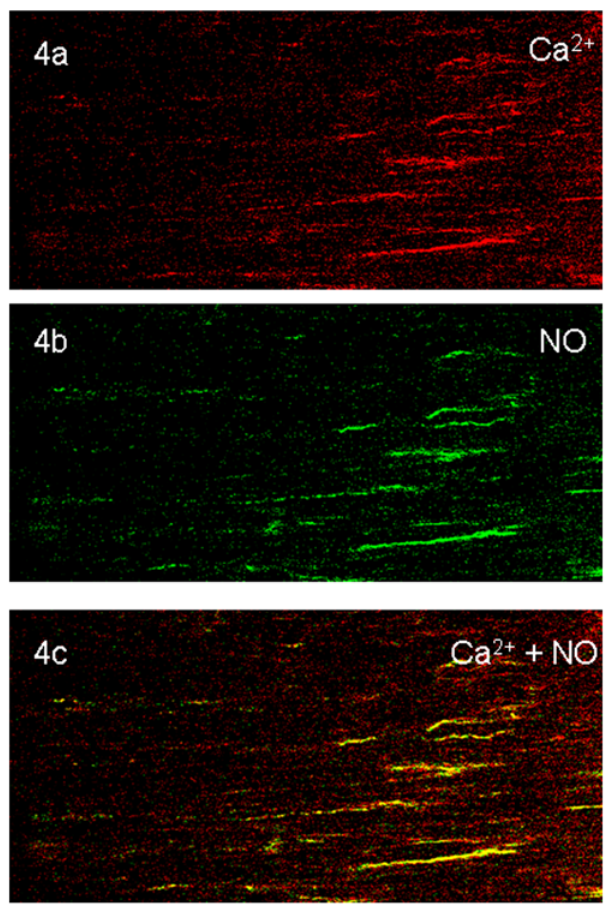
Figure 4. Colocalization NO signals with nNOS immunoreactive varicosities. In this experiment the muscle strip that was preloaded with DAF-2 under NANC conditions, applied EFS and then fixed was immunostained with anti-nNOS antibody. The NO signals are long lasting as the reaction of NO with DAF-2 to form DAF-2T is irreversible. Top panel shows imaging for NO and reveals spots of green fluorescence, representing NO in the varicosities. Note that smooth muscle cells showed no NO signals. The middle panel shows the same section imaged for nNOS immunofluorescence. The bottom panel shows the merged image revealing that the NO and nNOS signals are superimposed indicating that NO was generated in the nNOS immunoreactive nerves. Note that no NO signals were seen in neighboring smooth muscle cells. (320 6 magnification). doi:10.1371/journal.pone.0004990.g004 Table 1. Influence of various treatments on relative quantification of NO and Ca 2 + signals.